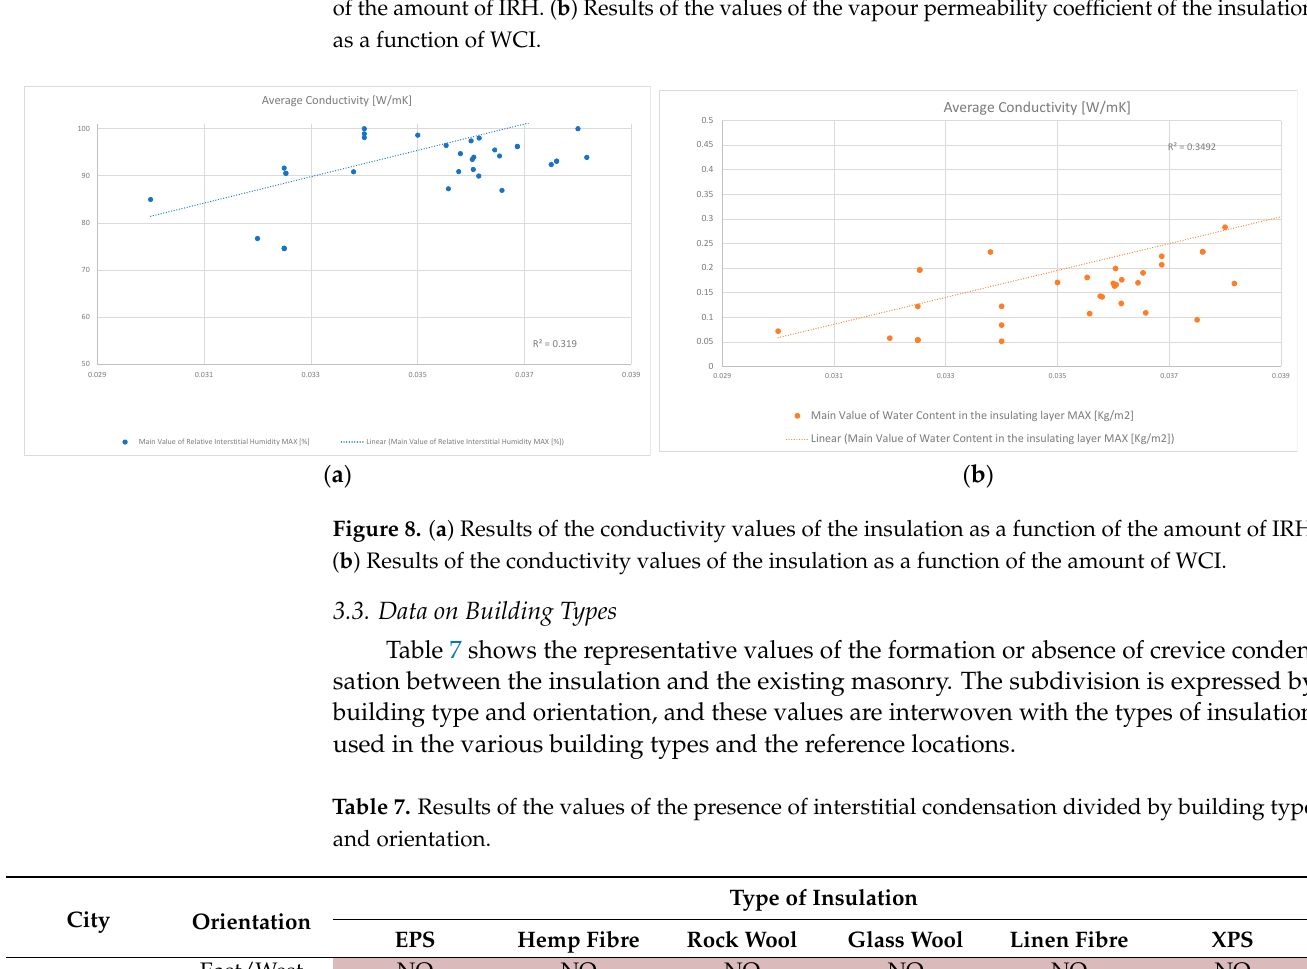
Table 7. Results of the values of the presence of interstitial condensation divided by building type and orientation.